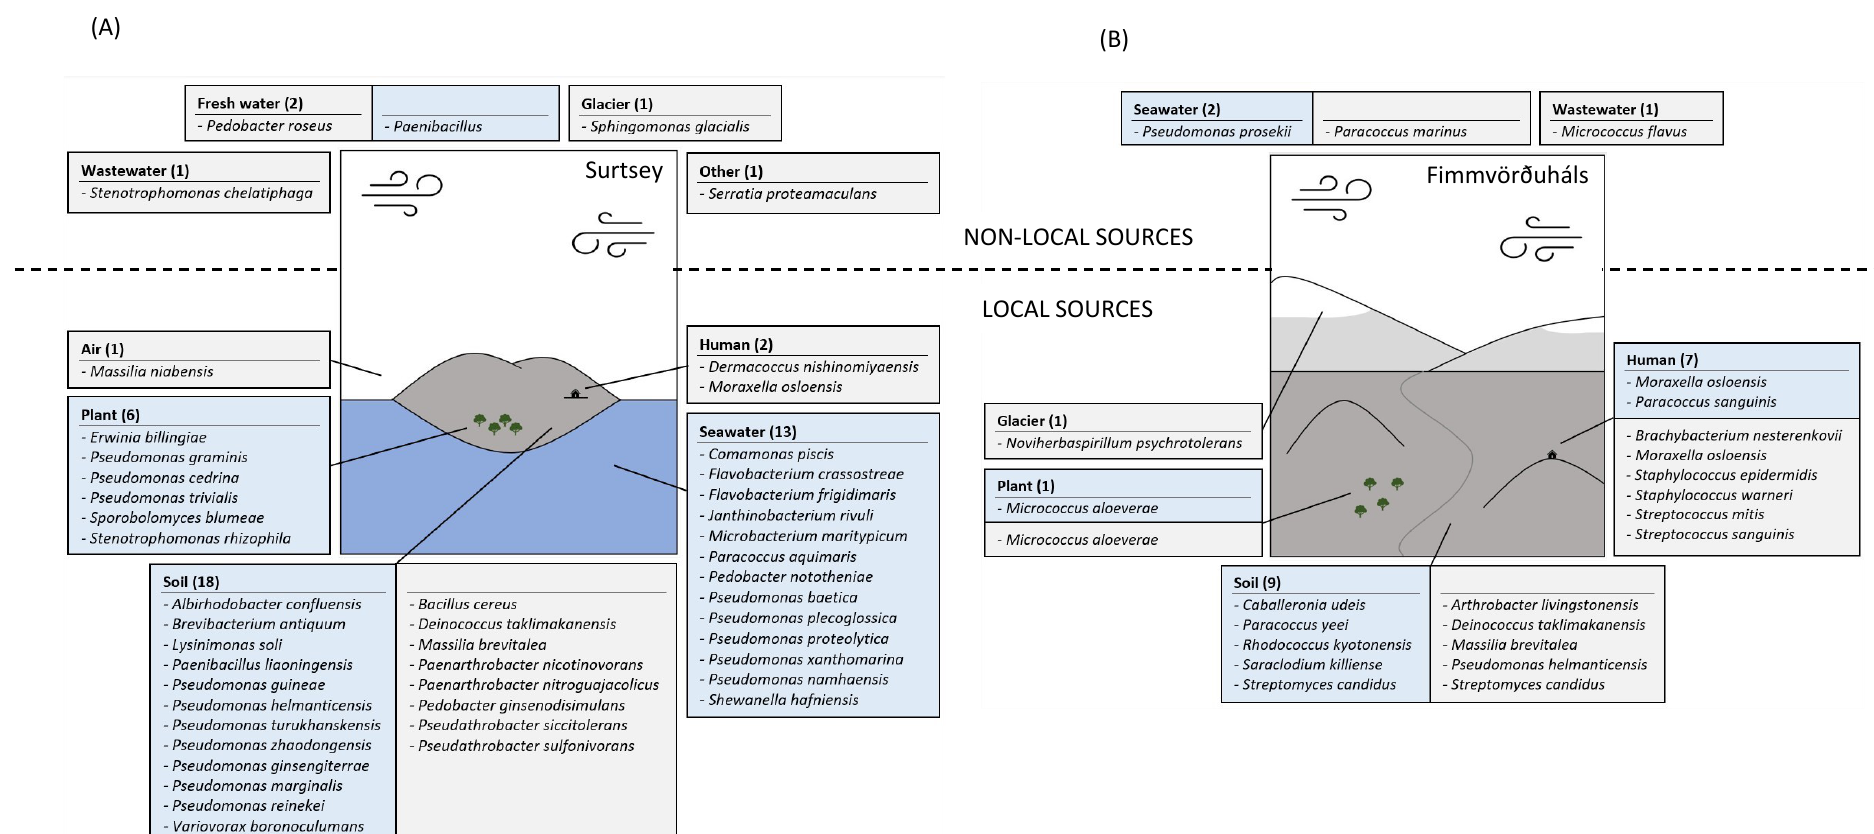
Figure 7. Overview of the predictive sources of the species-determined taxa cultivated from the air (blue) and the one-year-old lava rocks (grey) of Surtsey ( A ) and Fimmvörðuh á ls ( B ). The numbers represent the count of the different taxa per source.